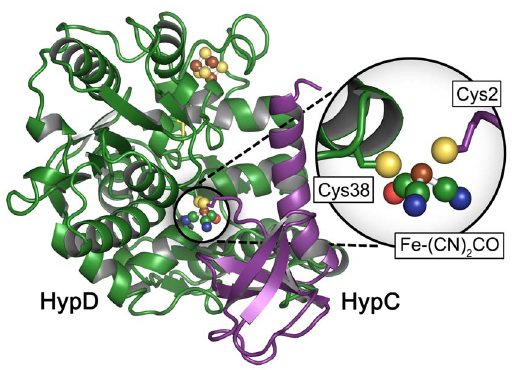
Figure 1. Mixed crystal structure/ homology model of the HypCD complex. The model consists of a R. leguminosarum HypC homology structure superimposed onto the crystal structure of HypCD from T. kodakarensis [20]. Fe–(CN) 2 CO was added to the N–terminus of HypC (Cys2) with the iron ion in close proximity to Cys38 of HypD and optimized in an aqueous environment. The Fe–(CN) 2 CO cofactor has been added to the model in silico [19].